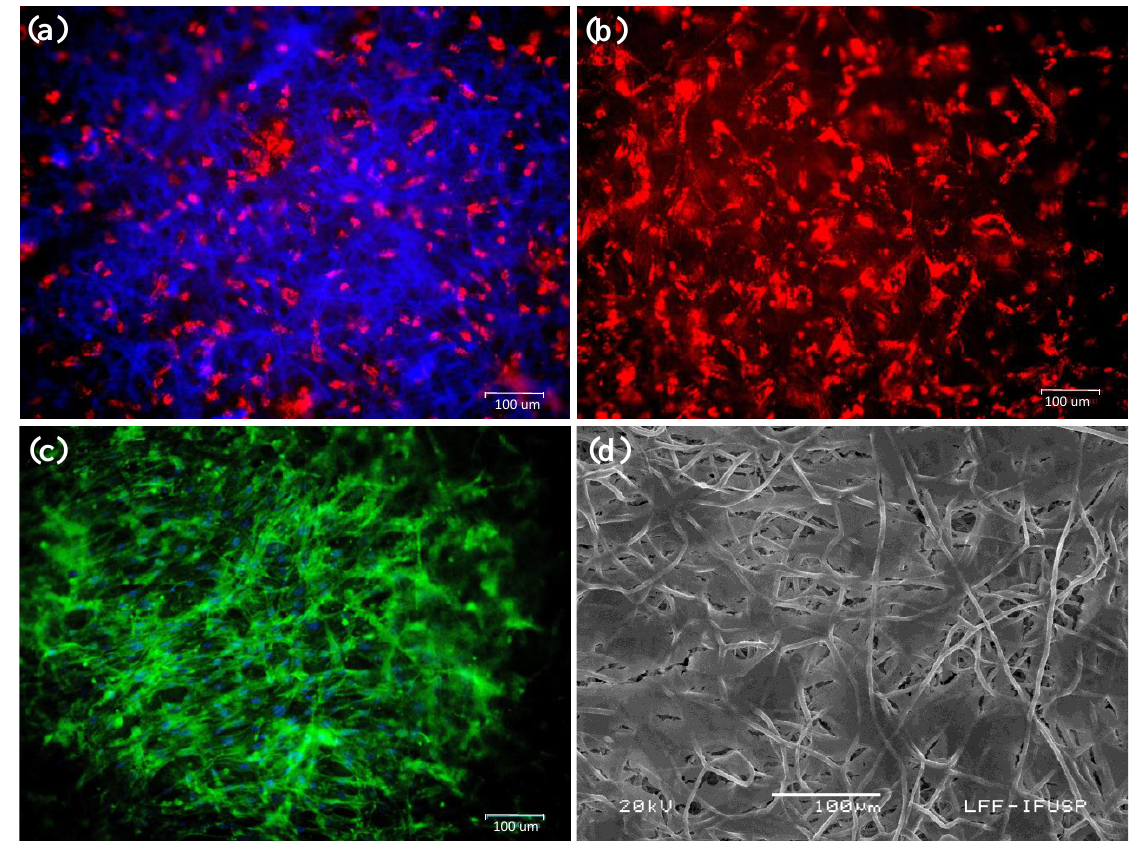
Figure 4. The hASCs seeded on PDO membranes. Cells were stained with ( a ) PHK26 and Hoechst solution 4 h after incubation on the membrane, ( b ) PHK26, and ( c ) FITC after 24 h of incubation. ( d ) SEM image of hASCs after 11 days on the membrane.